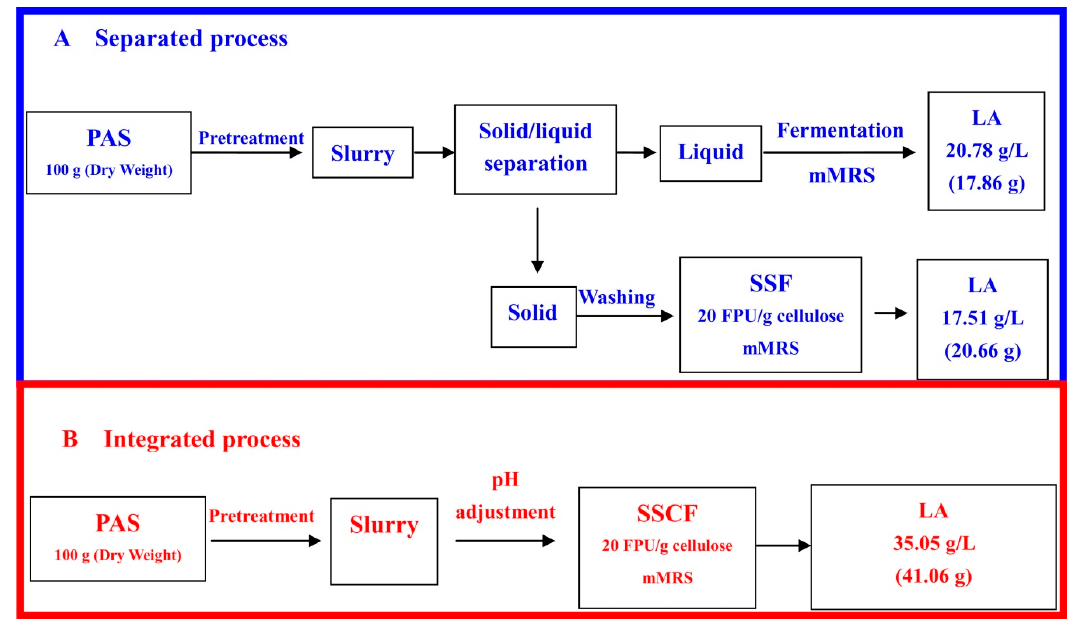
Figure 6. Mass balance analysis of lactic acid (LA) production from PAS by the separated process ( A ) and the integrated process ( B ).